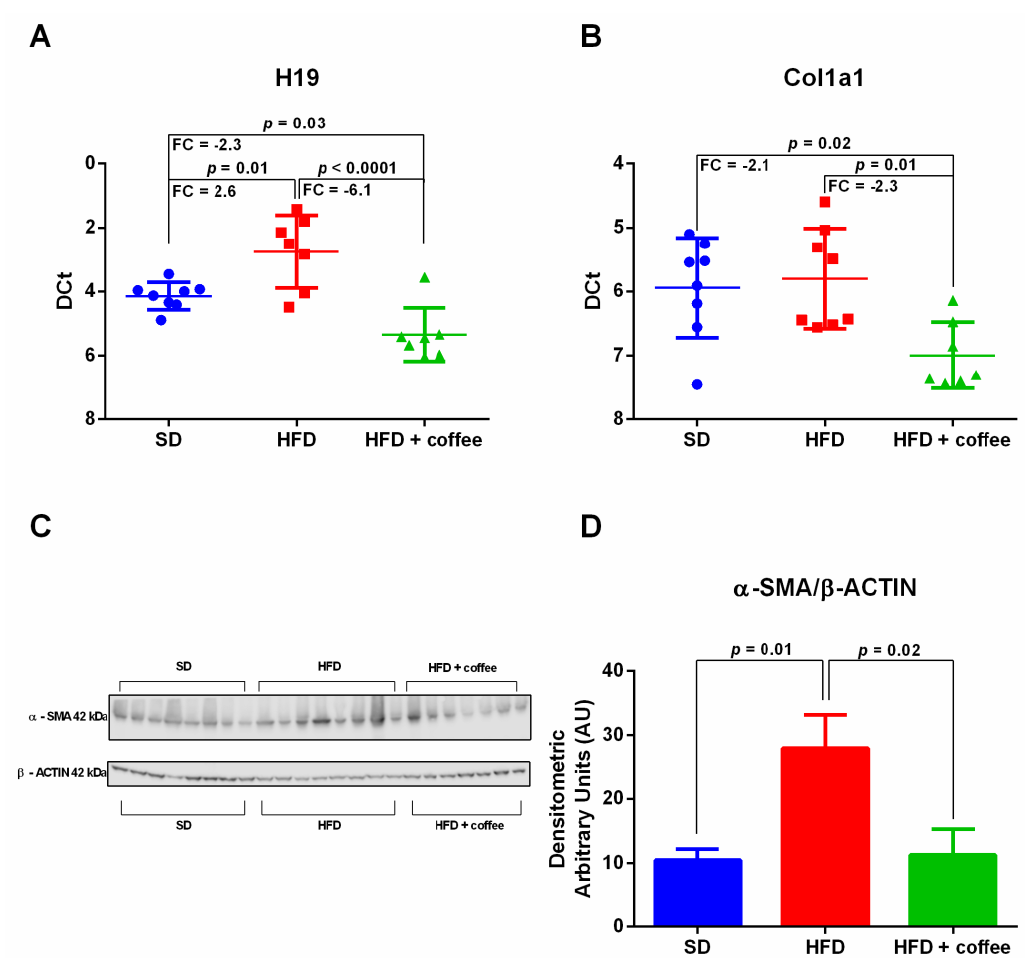
Figure 3. Hepatic expression of H19 lncRNA (Panel A ) and Collagen alpha-1(I) chain (Col1a1) mRNA (Panel B ), analyzed through qPCR, in mice fed standard diet (SD), high fat diet (HFD) and HFD plus decaffeinated coffee. Transcript statistical significance was evaluated with one-way ANOVA with Tukey post-hoc test for multiple comparisons (two-tailed p -value < 0.05); FC = fold change. Liver expression of alpha-smooth muscle actin ( α -SMA) protein, analyzed by Western blot (Panel C ), and relative densitometry normalized for the housekeeping β -actin (Panel D ). n = 23: 8 SD, 8 HFD, 7 HFD+